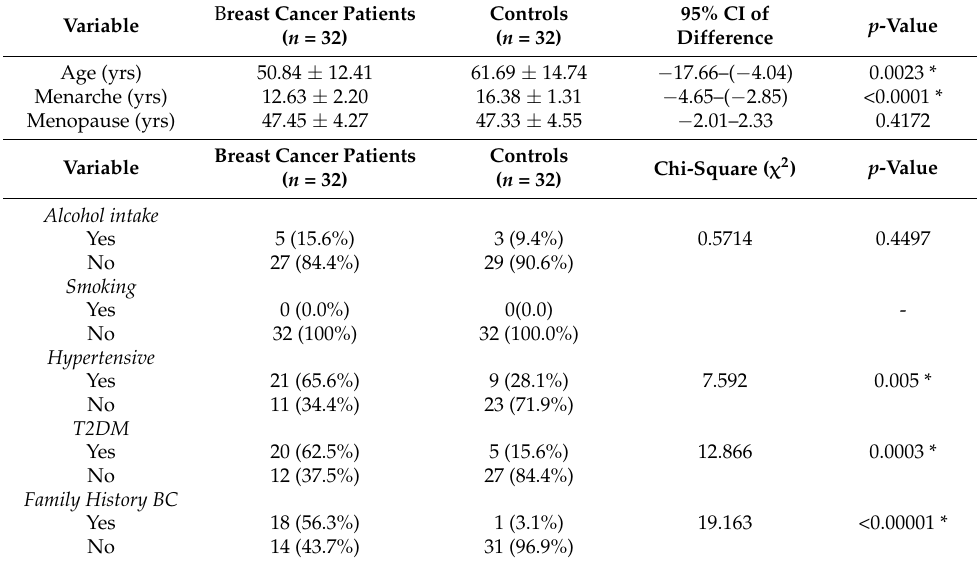
Table 1. Socio-demographic characteristics of study population.